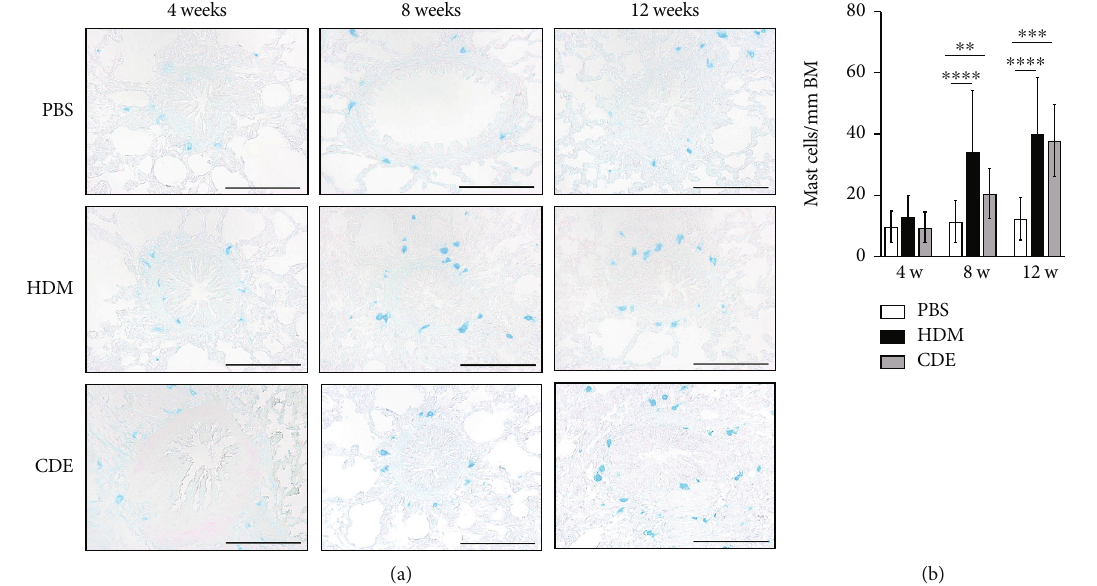
Figure 5: Repetitive allergen exposure induces a marked accumulation of mast cells in guinea pig airways. (a) Representative histological sections of Astra blue-stained lungs, and (b) quanti fi cation of mast cells within the airway subepithelial region. Mast cells were expressed as cell number/BM perimeter (mm). Data are mean ± SD of n = 4 -5 animals per group. Scale bars correspond to 100 μ m. ∗∗ P < 0 : 01 , ∗∗∗ P < 0 : 001 , and ∗∗∗∗ P < 0 : 0001 . BM: basement membrane; HDM: house dust mite extract; CDE: cat dander